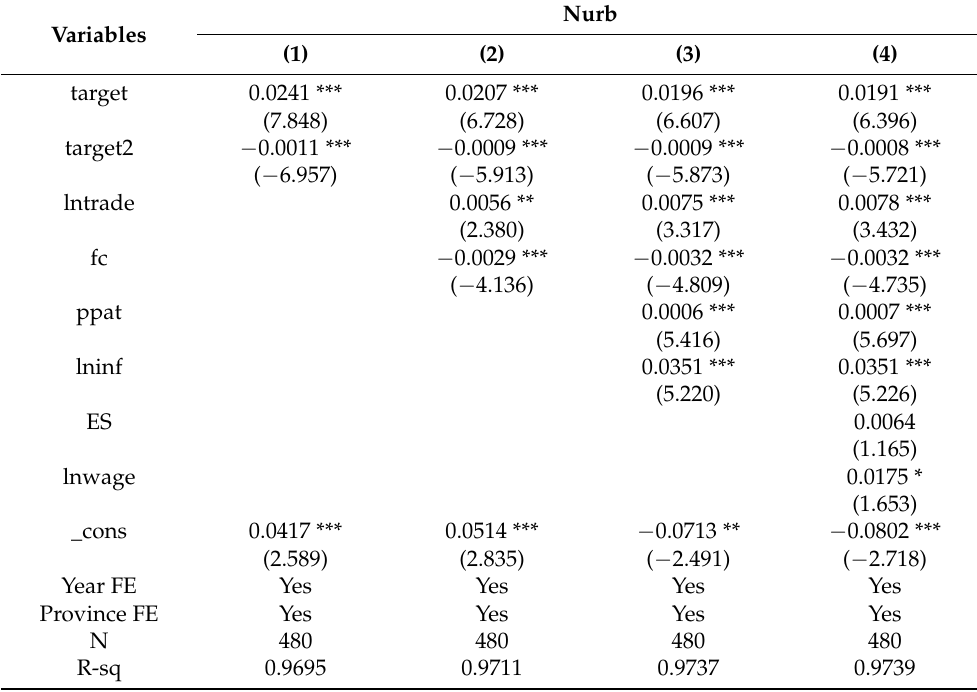
Table 3. Impact of economic growth targets on the level of urbanization